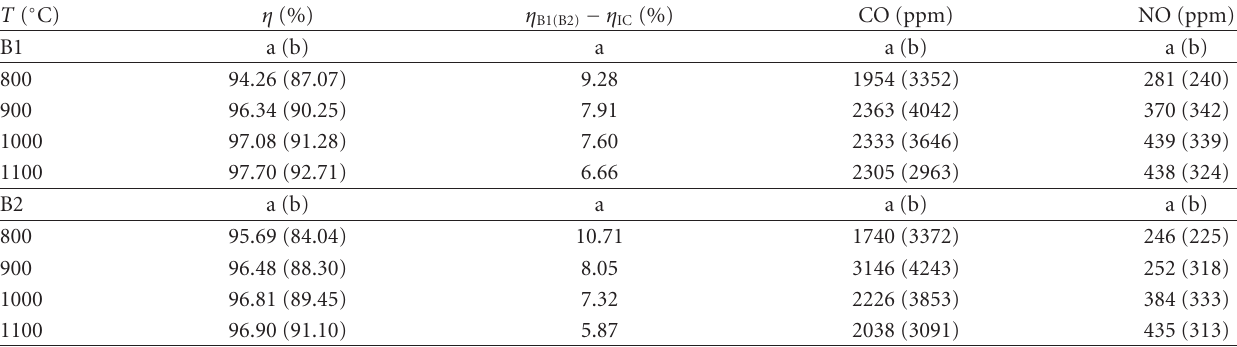
Table 3: Comparison of η , CO, and NO emissions between experimental value and calculated value and the enhancement of the η by blending.